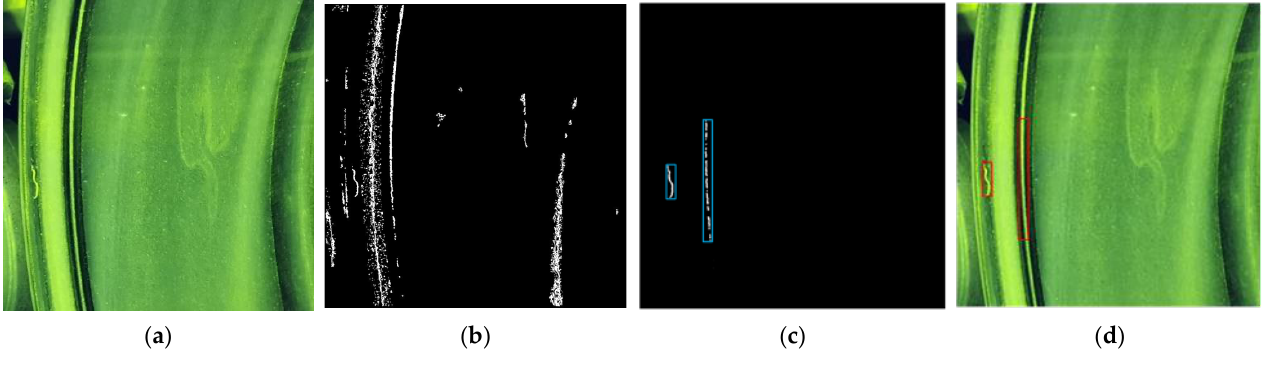
Figure 5. ( a ) Input image of the bearing ring; ( b ) Centerline result by using the Steger algorithm; ( c ) Result after using the Gaussian similarity measure; ( d ) Result of the candidate regions.